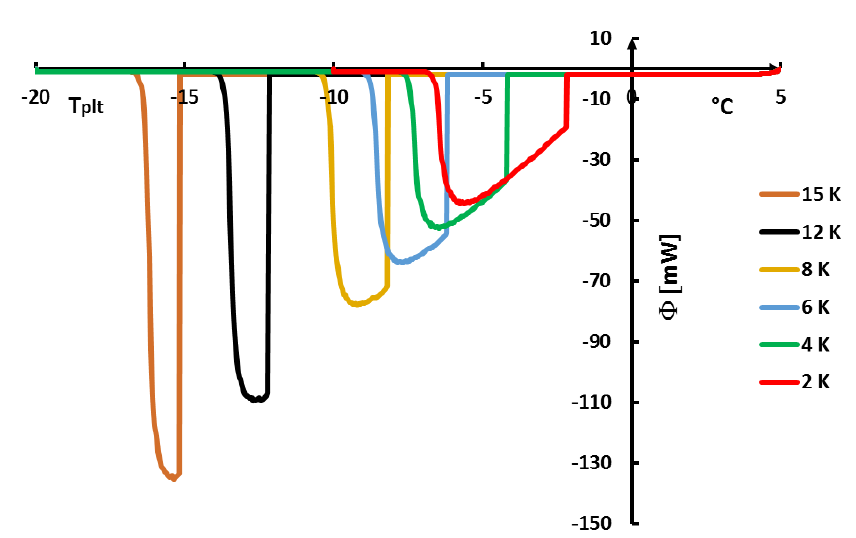
2 K/min for different supercoolings T F −